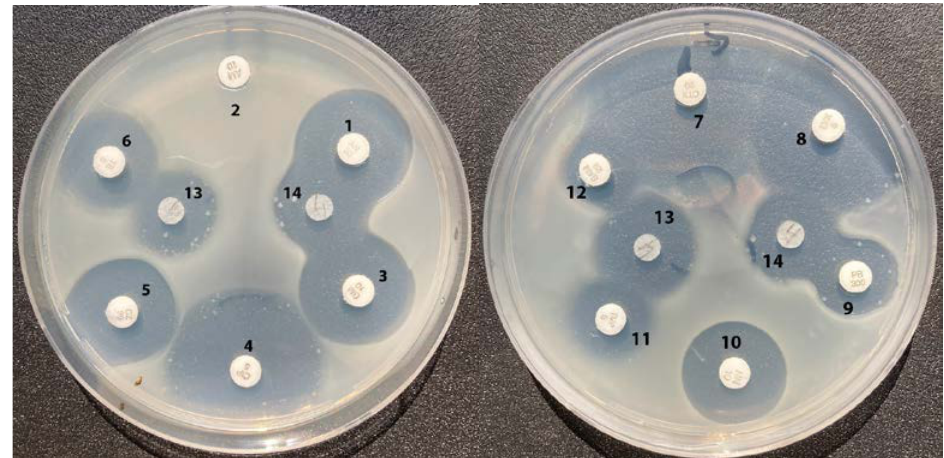
Figure 4. Inhibition of the growth of reference strain Klebsiella pneumoniae ATCC 13,883 with antibi- otics and peptide derivatives of phosphinothricin. ( 1 ) Amikacin, 30 µg/disk; ( 2 ) Ampicillin, 10 and peptide derivatives of phosphinothricin. ( 1 ) Amikacin, 30 µ g/disk; ( 2 ) Ampicillin, 10 µ µg/disk; ( 3 ) Gentamicin, 10 µg/disk; ( 4 ) Ciprofloxacin, 5 µg/disk; ( 5 ) Cefazolin, 30 µg/disk; ( 6 ) Tet-